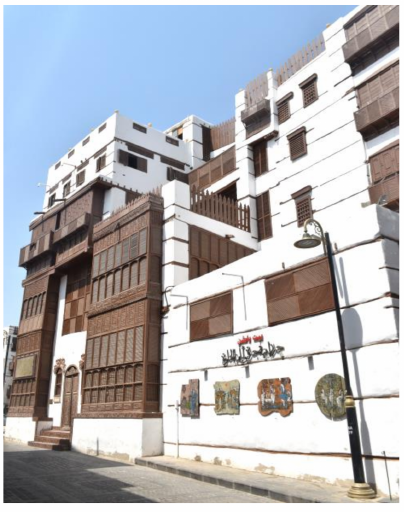
Figure 8. The building from outside.